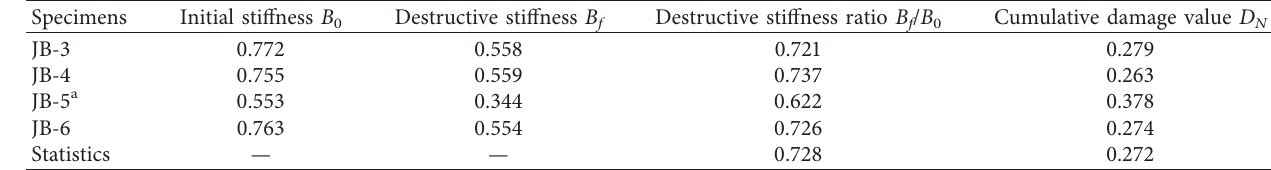
Table 3: Analysis results of bending stiffness of reinforced beams in fatigue tests.